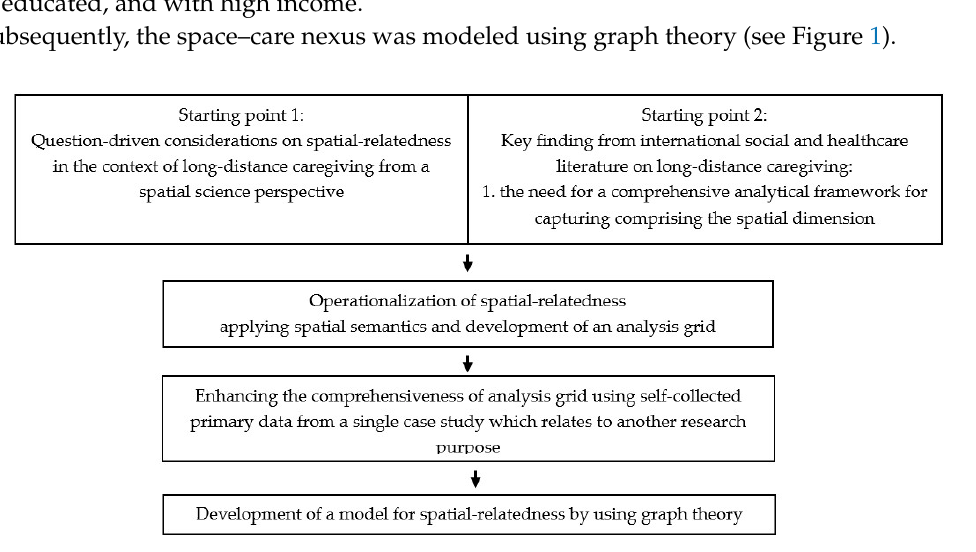
Figure 1. Methodological considerations on the research procedure. Own illustration.